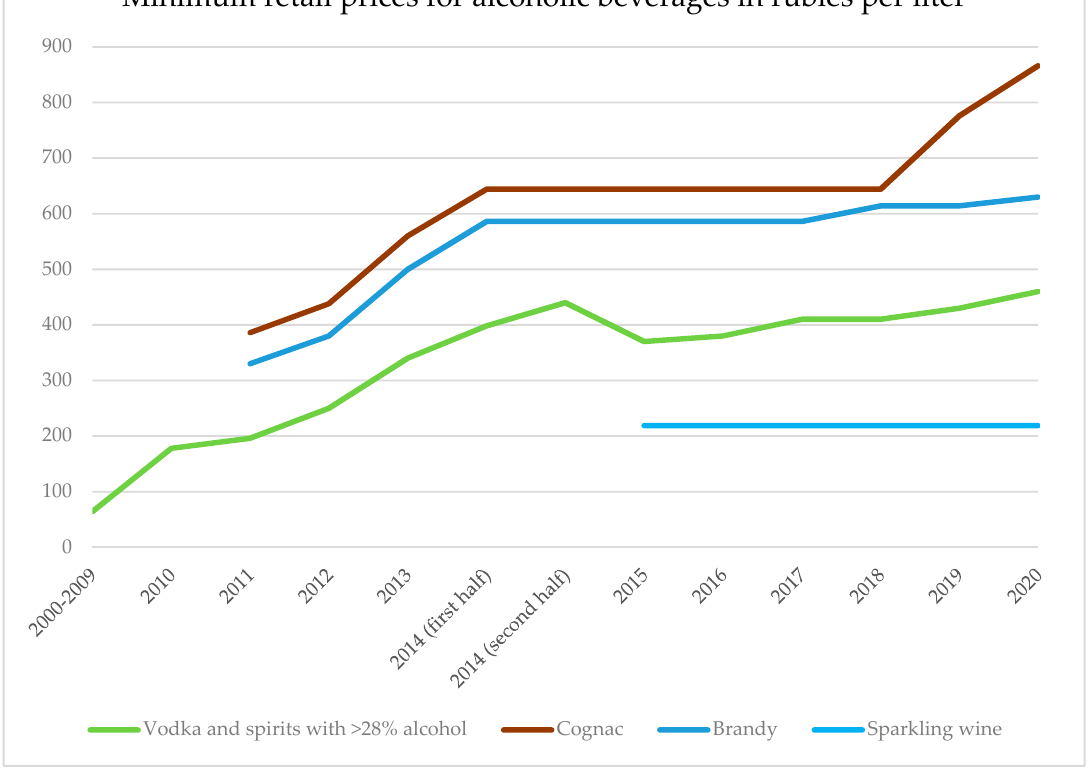
Figure 2. Minimum retail prices for different alcoholic beverages in rubles per liter. Source: Ministry of Finance of the Russian Federation.